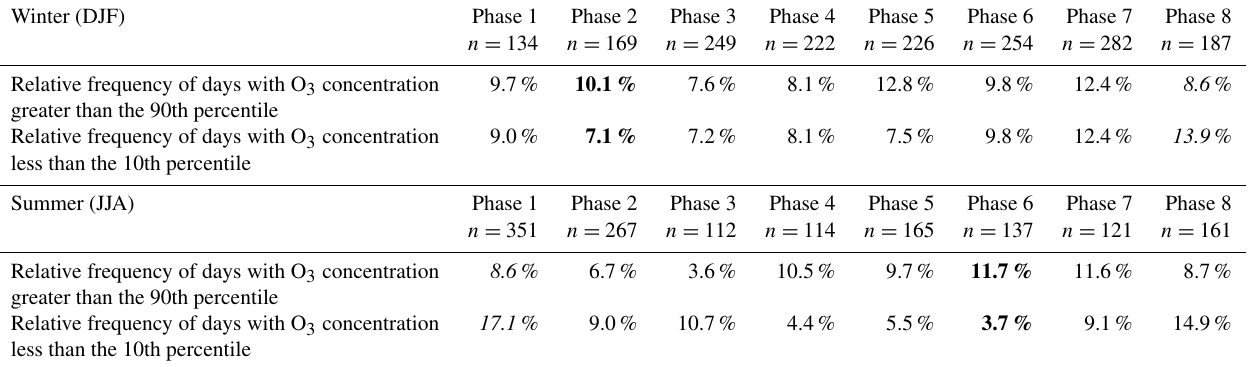
Table 2. Relative frequency of extreme ozone days in winter (top two rows) and summer (bottom two rows). A high ozone day was defined as one with a mean afternoon (12:00 to 16:00LT) ozone anomaly across the five observing stations greater than the long-term (1986–2014) 90th percentile. Similarly, a low ozone day was defined as one with a mean afternoon anomaly across the 5 observing stations less than the long-term 10th percentile. Values in bold (winter phase 2; summer phase 6) indicate phases with highest mean ozone concentrations in those seasons; values in italics (winter phase 8; summer phase 1) indicate phases with lowest mean ozone concentrations in those seasons. The number of days ( n ) in each active phase is given for each season, and is used to estimate the relative frequency. Winter (DJF) Phase 1 Phase 2 Phase 3 Phase 4 Phase 5 Phase 6 Phase 7 Phase 8 n = 134 n = 169 n = 249 n = 222 n = 226 n = 254 n = 187 greater than the 90th